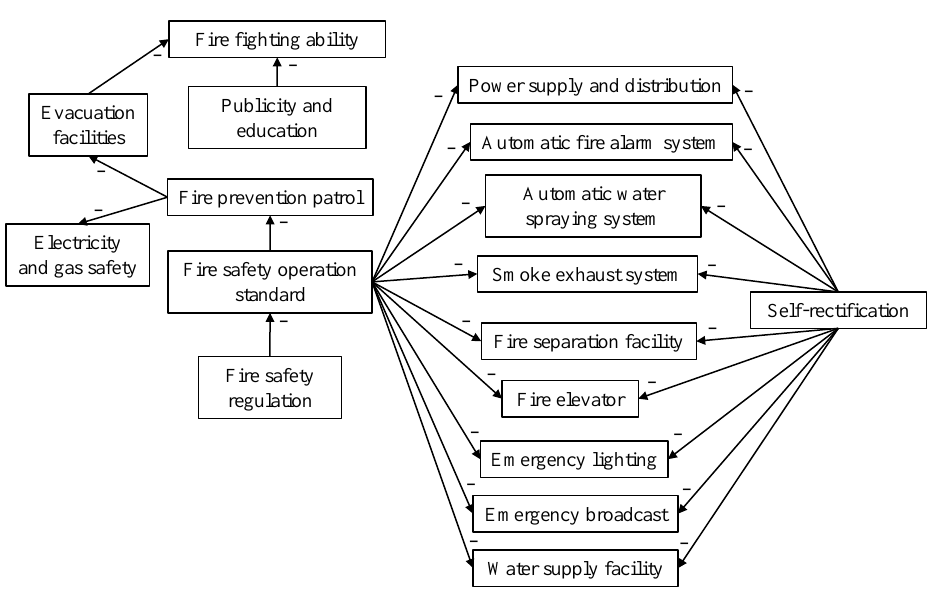
Figure 5. The coupling relationships among factors. In Figure 5, each arrow represents a cause and effect pair. The direction of the arrow points from the causal factor to the affected factor, and a minus sign above an arrow means that the cause will lower the performance of the affected factor, which is explained